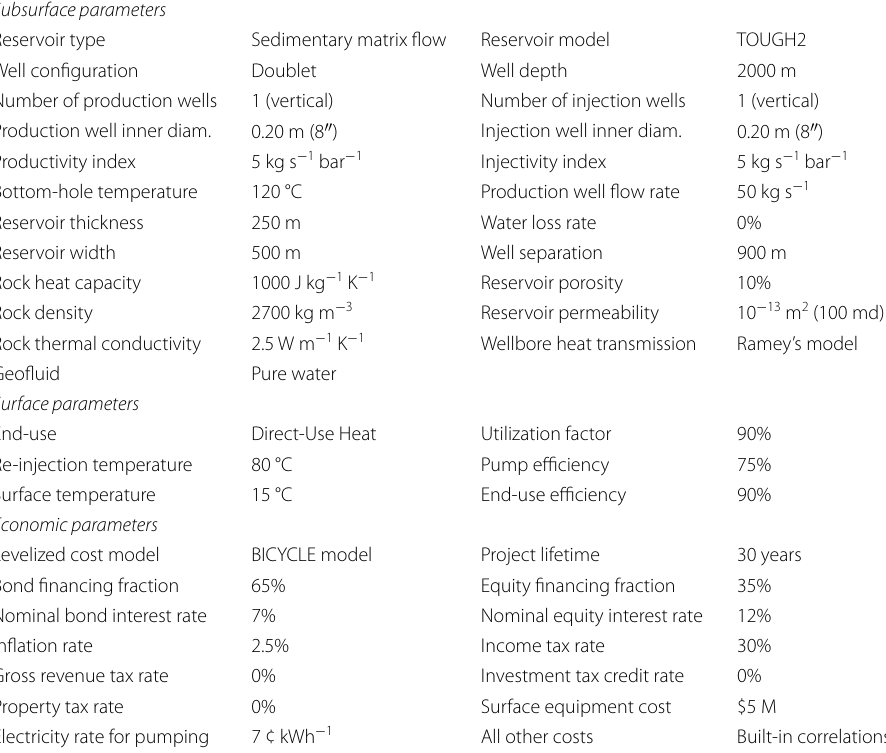
Table 1 GEOPHIRES input parameters for example simulation